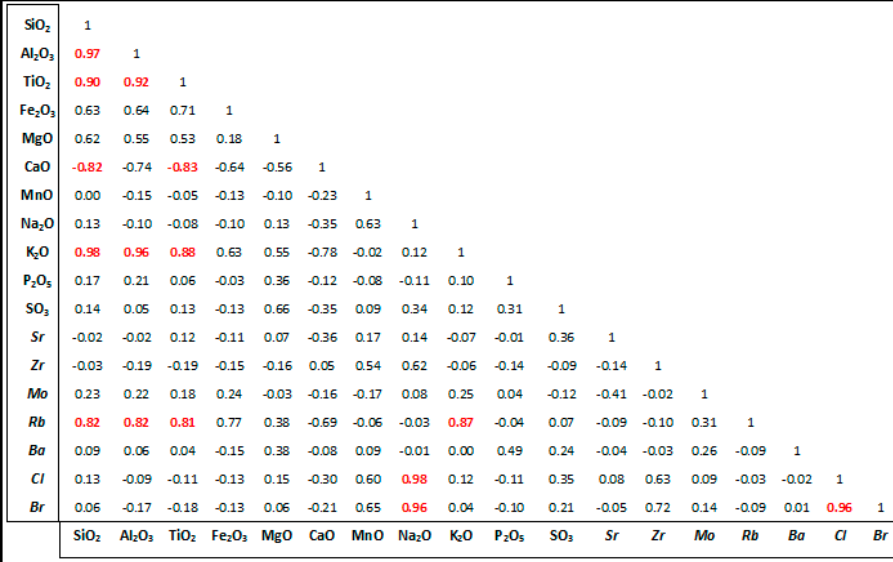
Figure 6. Correlation coefficient matrix for the chemical components in the studied travertine.